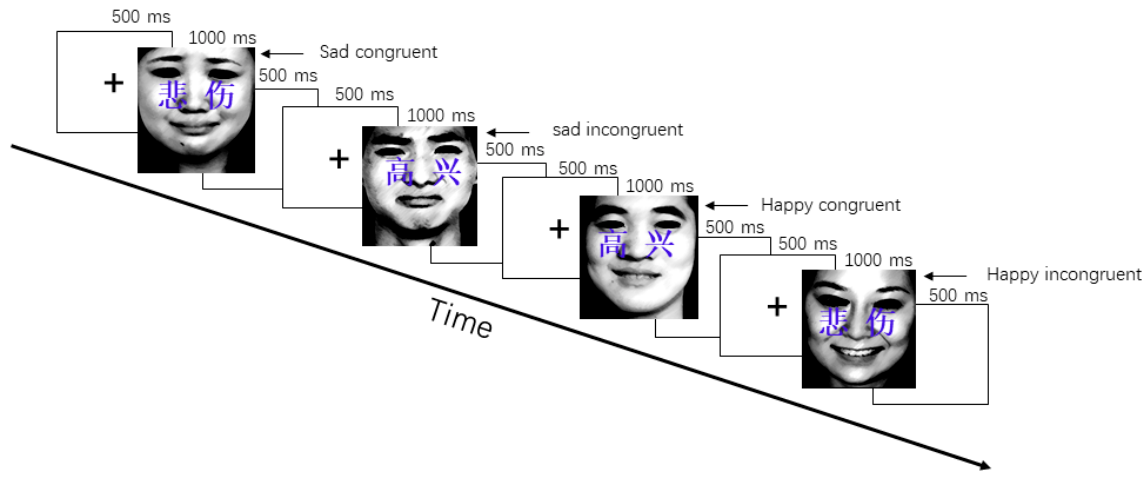
Figure 1. Example of the conflict paradigm. The flow-chart shows the time order of trials, which were completely randomized. The characters on the faces read sad ( 悲伤 ) and happy ( 高兴 ).